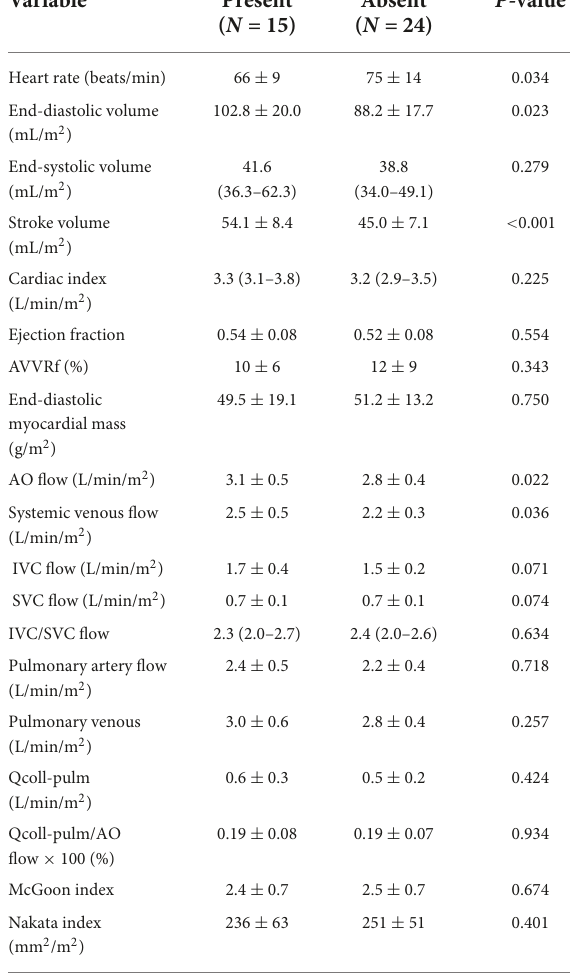
TABLE 7 Liver nodules and magnetic resonance imaging (MRI)